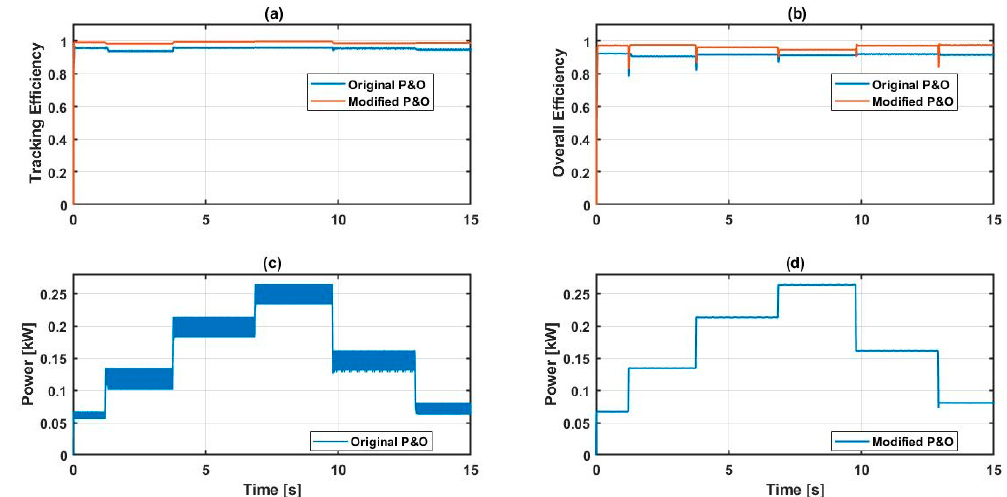
Figure 8. Low-power PV system with comparison of ( a ) tracking efficiency; ( b ) overall system efficiency; ( c ) original P&O PV output power; and ( d ) modified P&O PV output power.